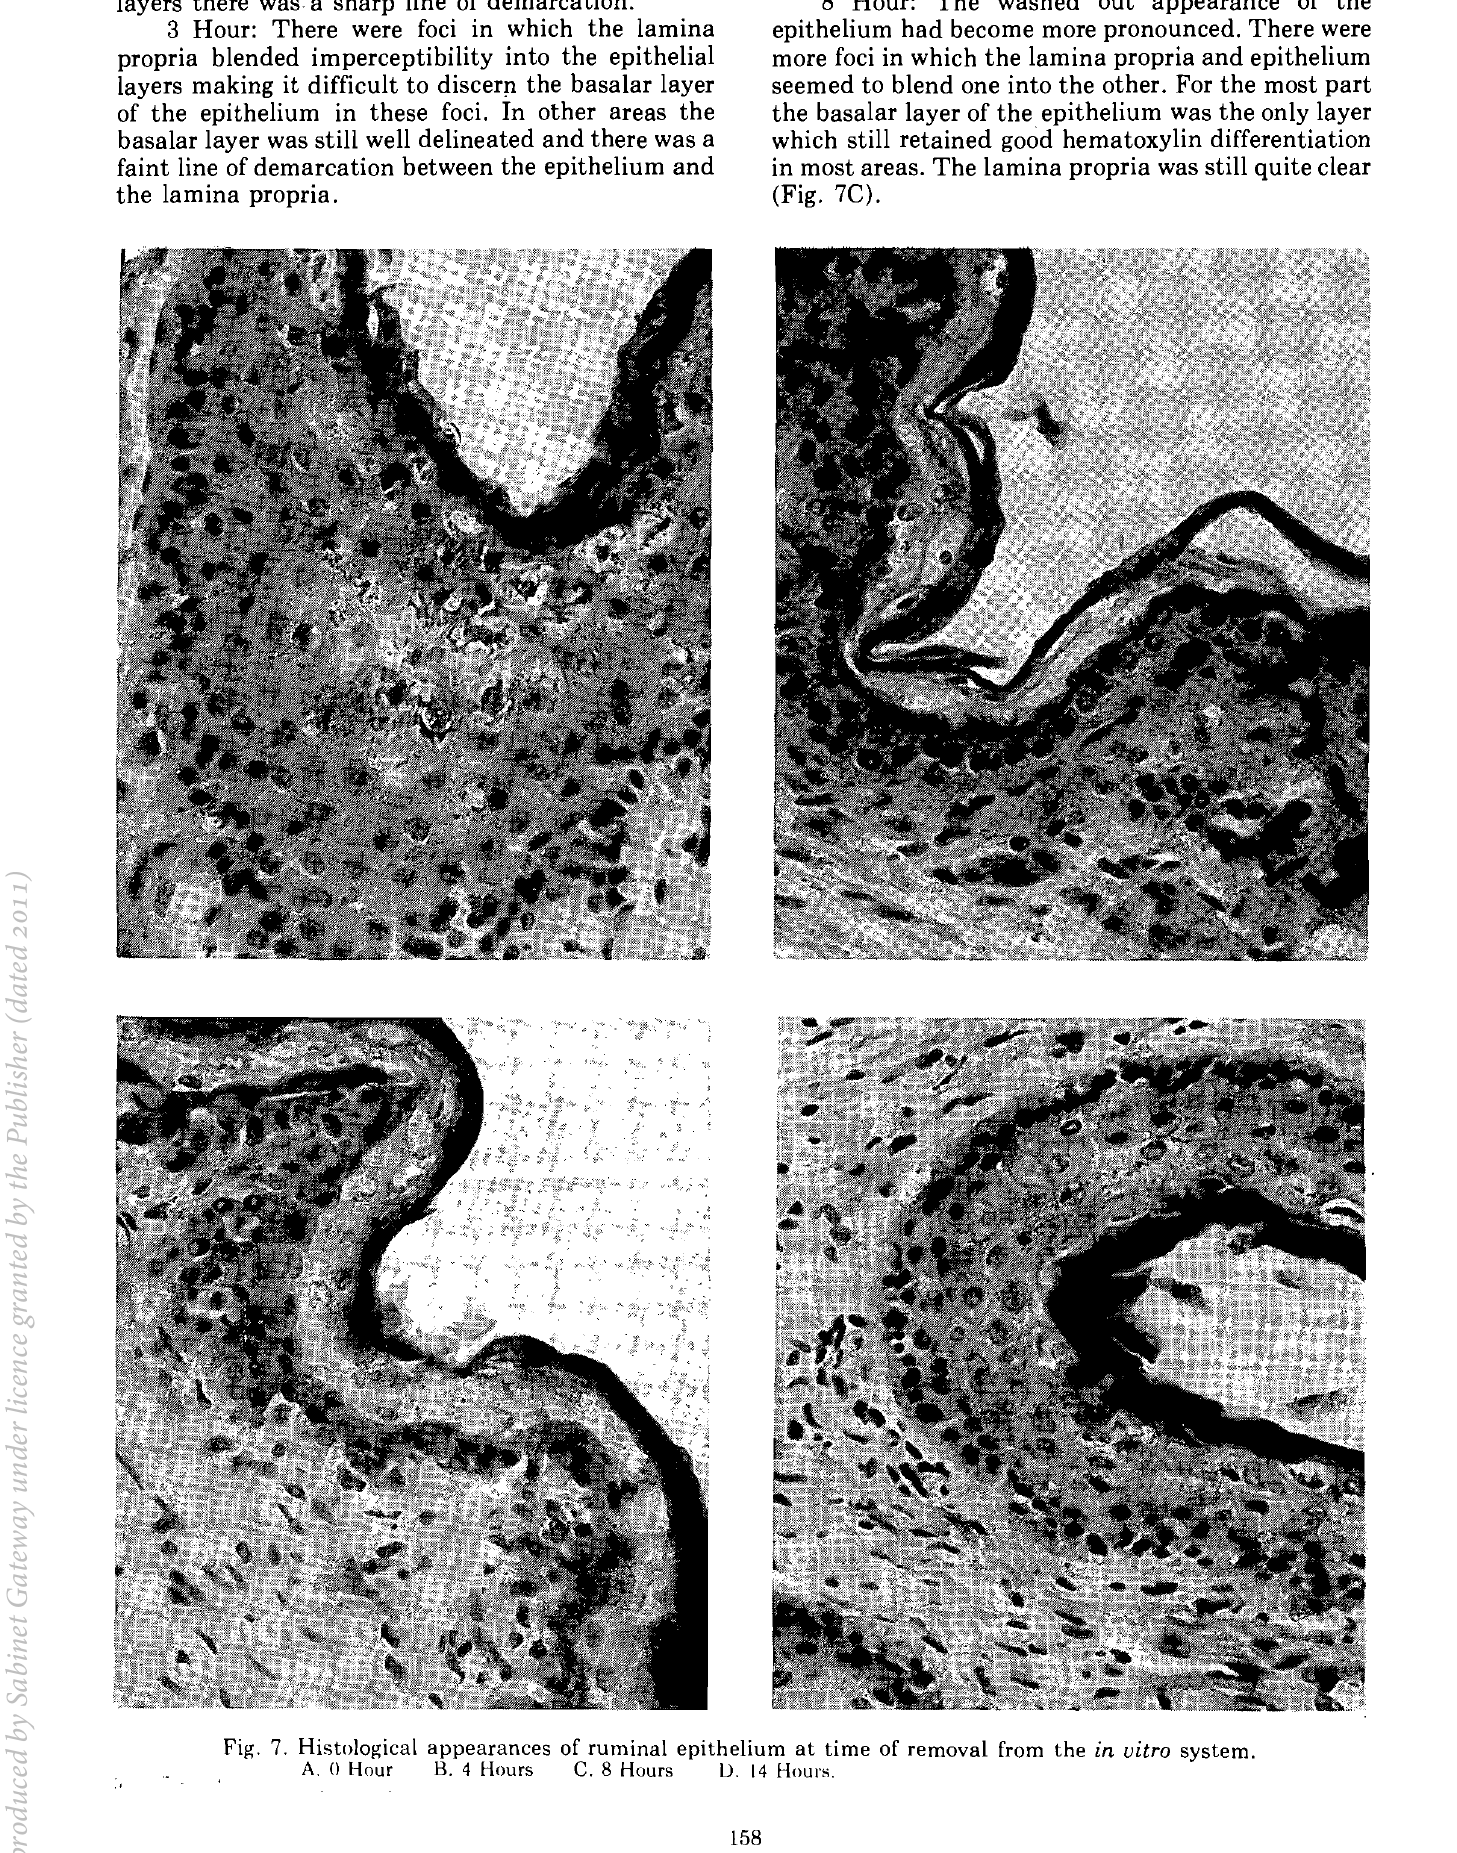
Fig. 7. Histological appearances of ruminal epithelium at time of removal from the in vitro system. . A. ()